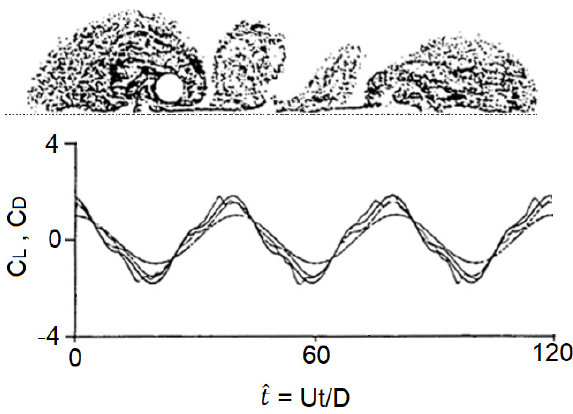
Figure 18. The flow pattern at t = 120, and the force coefficients for G/D = 0.5, Kc = 40 and Re = 25,000.